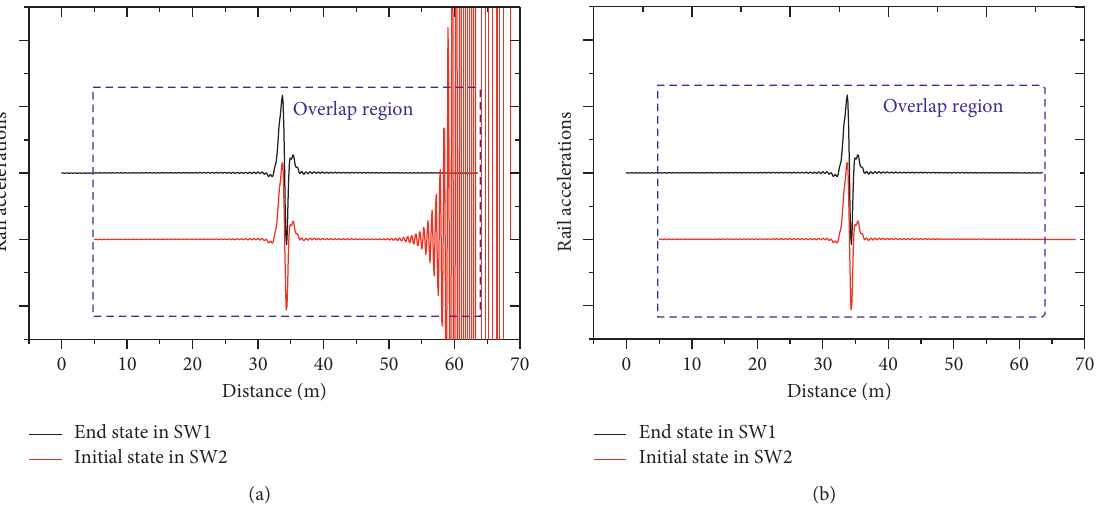
Figure 5: Transient states of the rail at the sliding moment when using (a) matrix’s triangular decomposition and (b) the least square